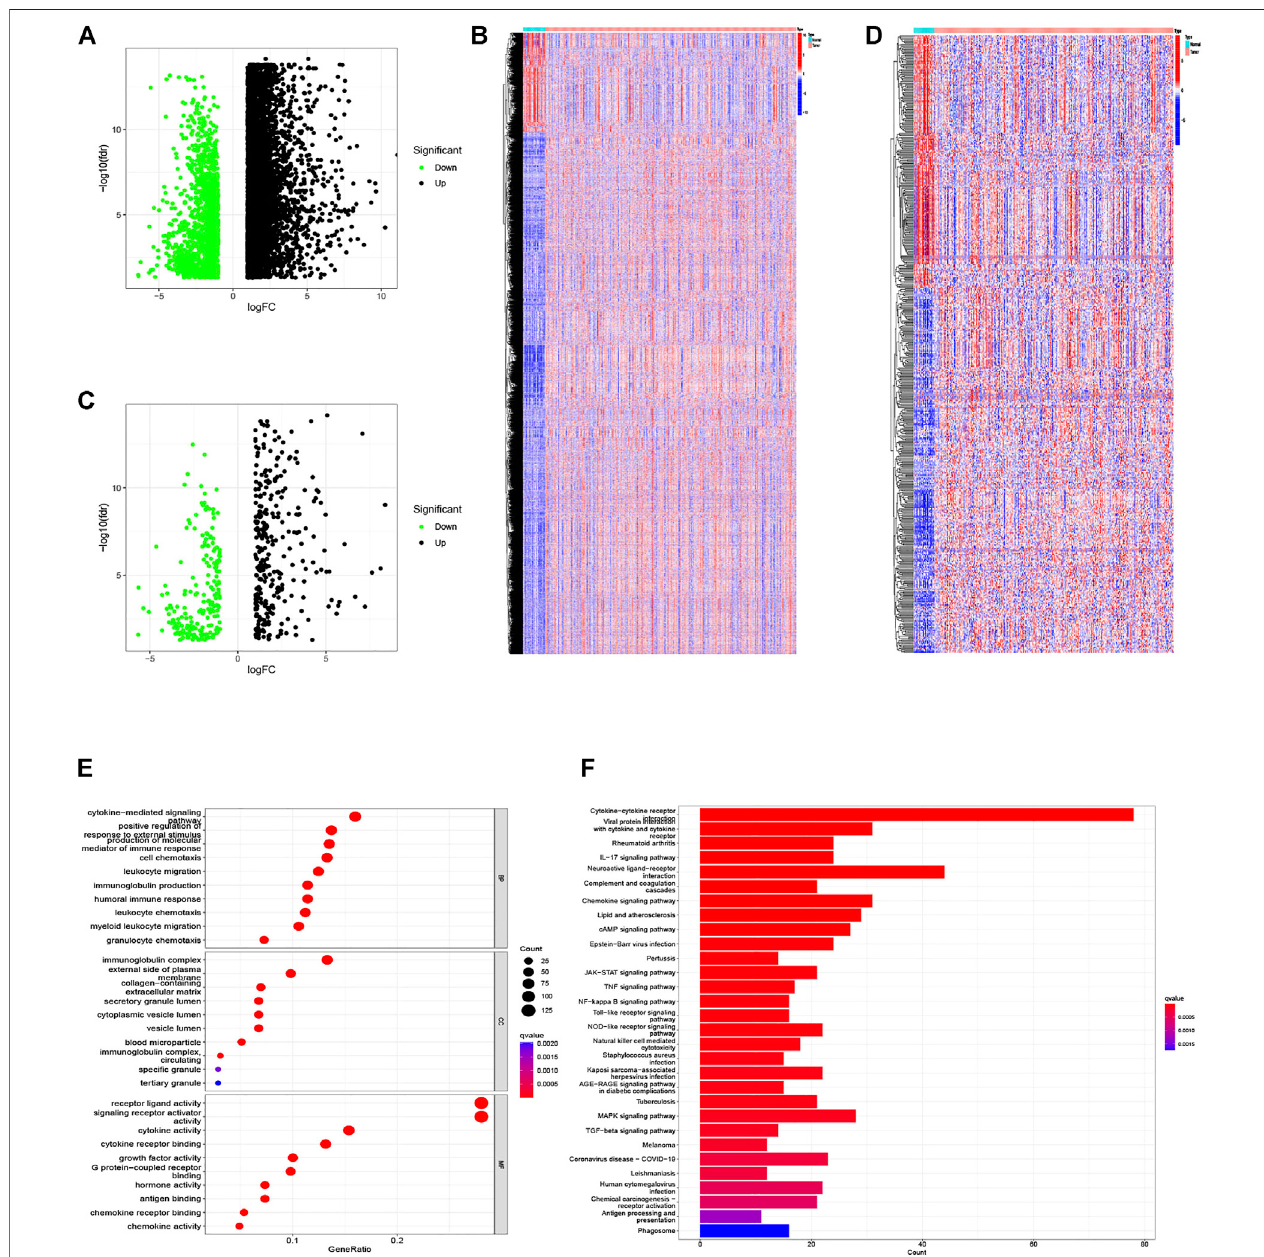
FIGURE1| DEGsanddifferentiallyexpressed IRGsbetweenGCandnormaltissues,andfunctionalenrichmentanalysisofdifferentiallyexpressed IRGs. (A,B) The volcano plot and heat map of DEGs in GC samples from the TCGA database. (C,D) The volcano plot and heat map of IRGs differentially expressed in our samples. (E) Barplot of GO enrichment. (F) Barplot of KEGG enriched